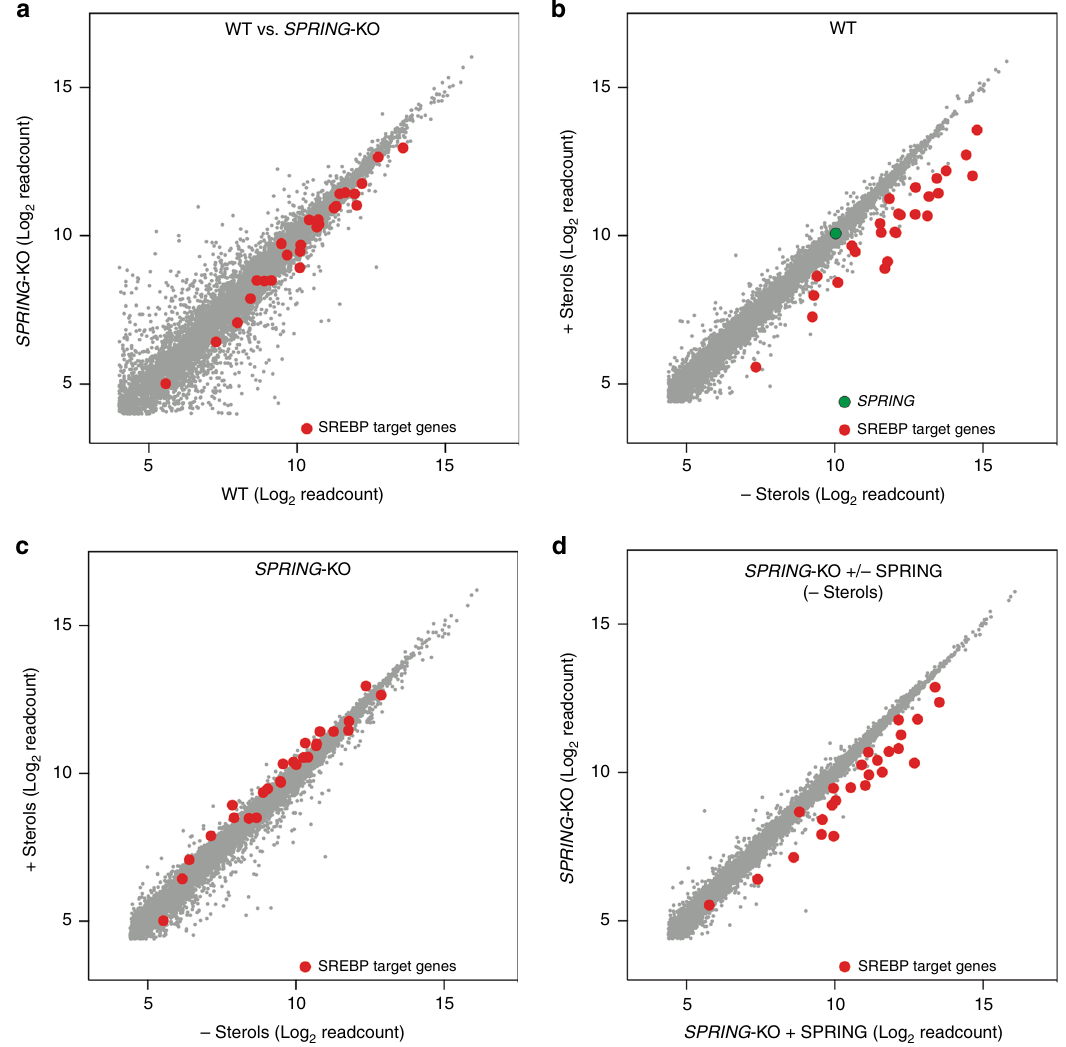
Fig. 3 Global SREBP-signaling requires SPRING. a – d Comparison of transcriptional pro fi les obtained by RNAseq of a Hap1-WT and Hap-SPRING KO cells, and b – d the transcriptional response of the indicated cells to sterol depletion. SREBP target genes ( HMGCR, HMGCS1, SQLE, ACACA, ACAT2, ACSS2, CYP51A1, DHCR24, DHCR7, EBP, FASN, FDFT1, FDPS, GGPS1, GGPS1, HSD17B7, IDI1, INSIG1, LDLR, LSS, MVD, MVK, NSDHL, PCSK9, SC5D, SCD1, SREBF2, TM7SF2 ) 4,18 are shown in red and SPRING in